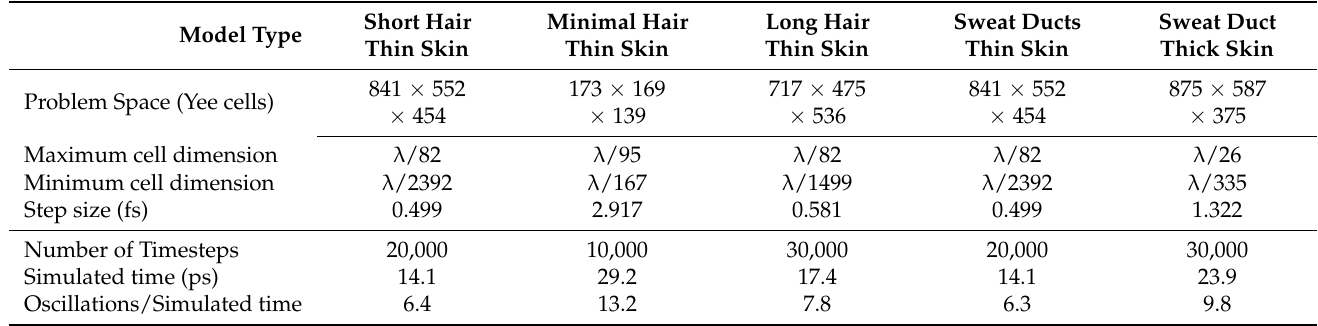
Table 1. Simulations at 0.45 THz ( λ = 0.667